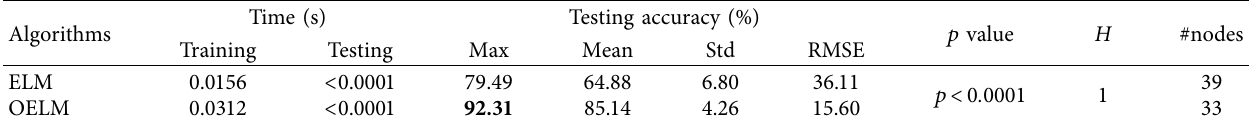
Table 5: Performance comparison of ELM and OELM for activation function